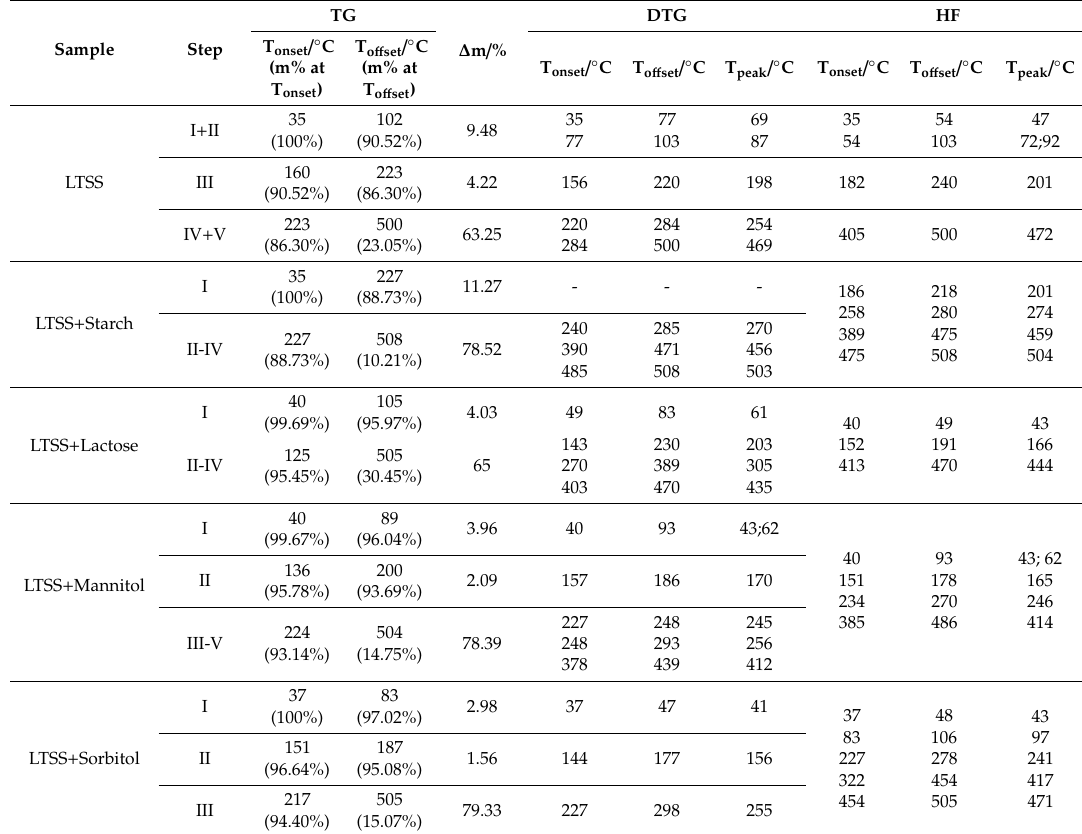
Table 2. Summarization of thermoanalytical data (TG / DTG / HF) obtained after thermal analysis of binary